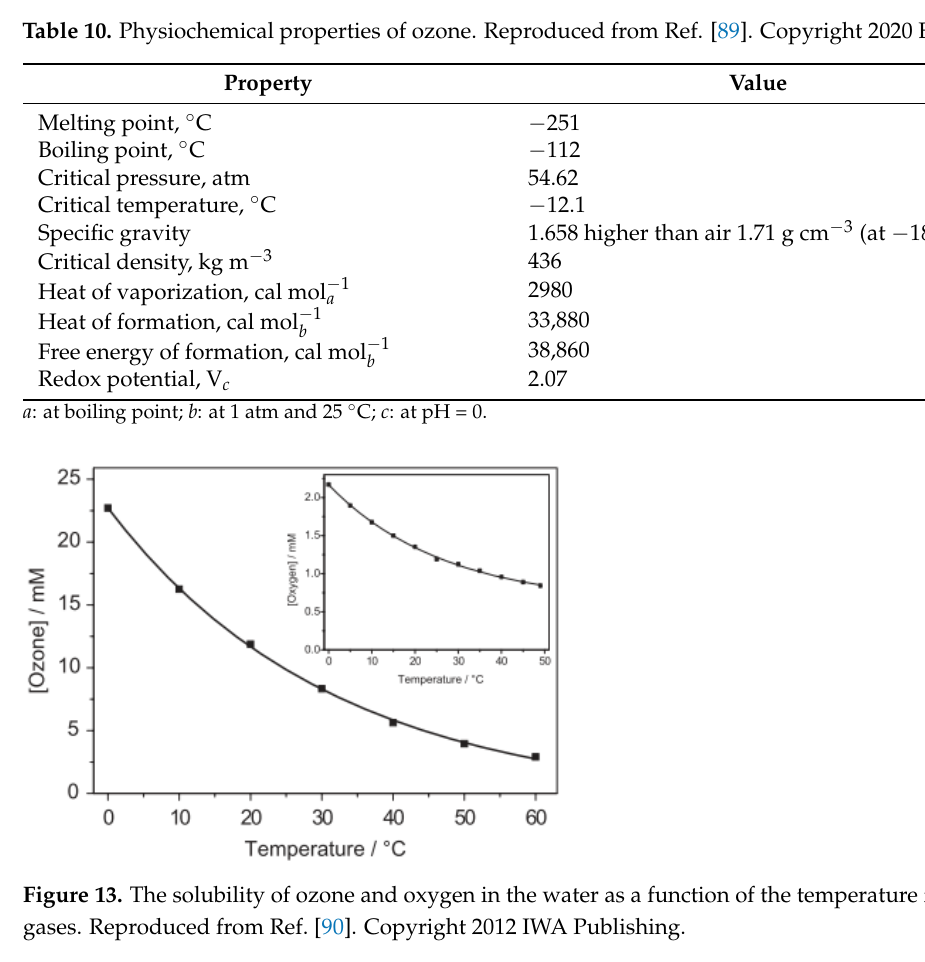
Figure 14. General schematic of reaction for ozonation of contaminants in an aqueous solution (M: metal, MO x : Metal oxide, and • OH: hydroxyl radical). Reproduced from Ref. [88]. Copyright 2001 SciELO.